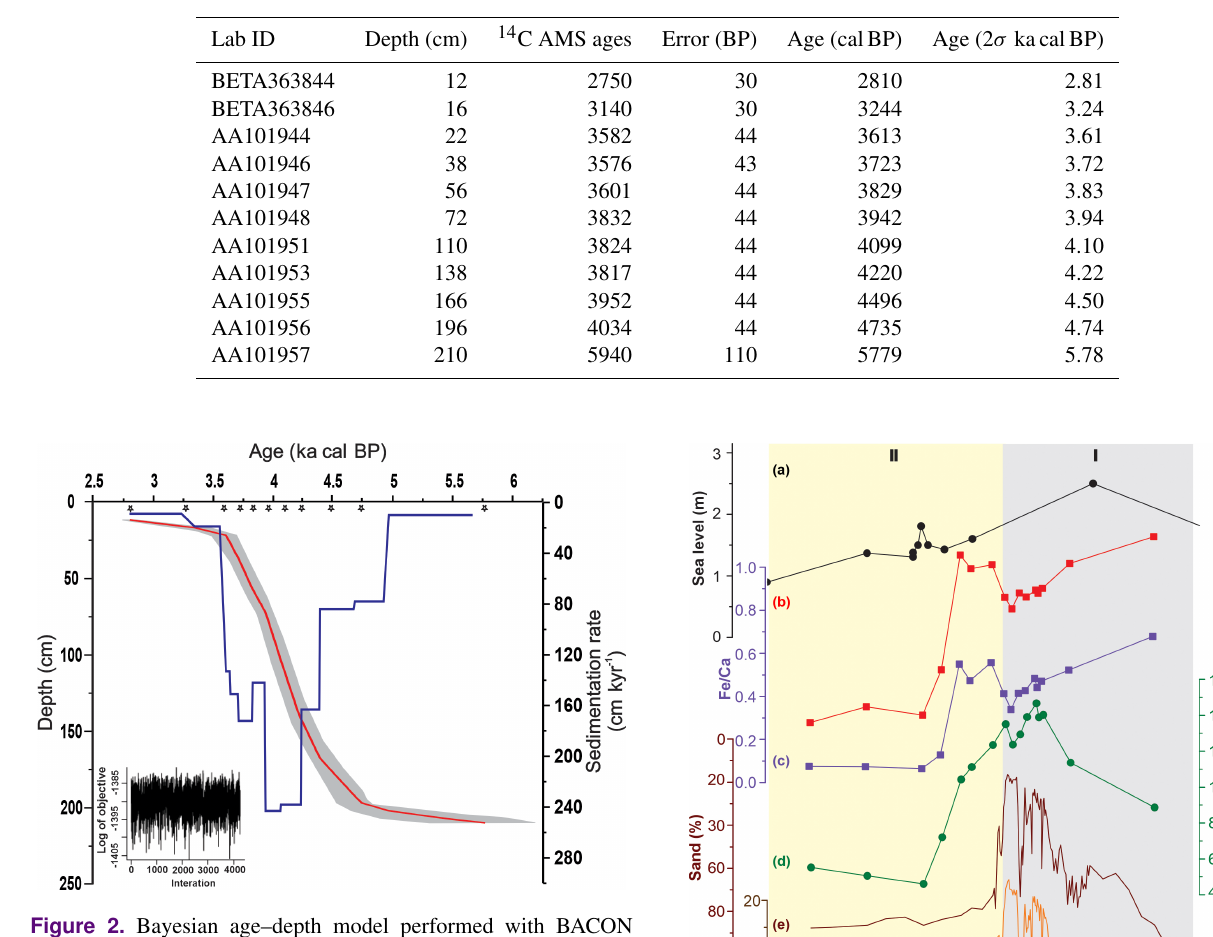
Table 2. Ages, 14 C, obtained from the dating of bulk organic matter to core S-15.